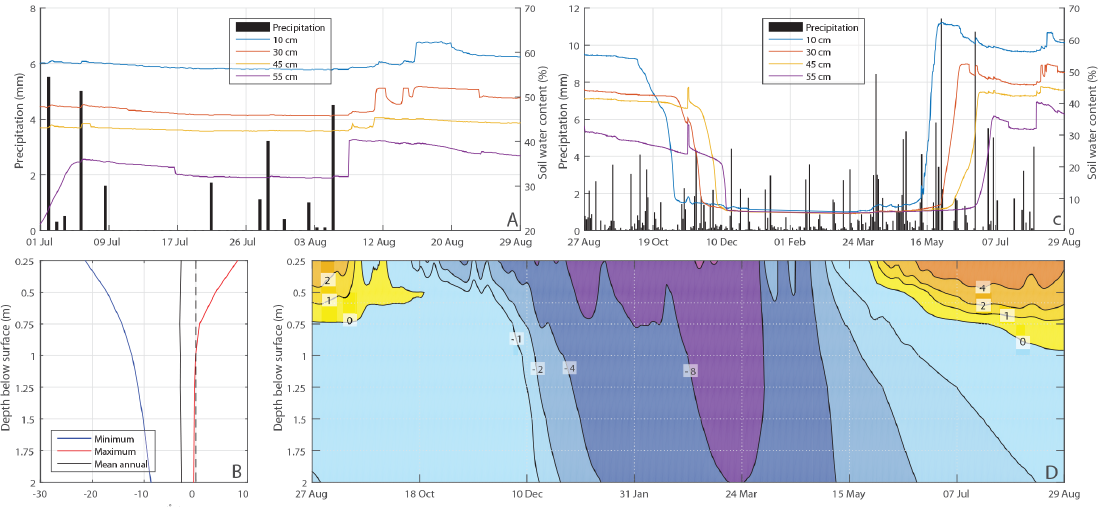
Figure 8. Soil water content (%) at different depths co-plotted with precipitation (mm) data from the AWS, during the active period in 2012 (a) and the same data for the full year August 2011–August 2012 (c) . Min, max, and mean soil temperature, ◦ C, as function of depth, based on data from August 2010 to August 2013 (b) . Soil temperature in the upper 2m from May 2012 to December 2012 (d)